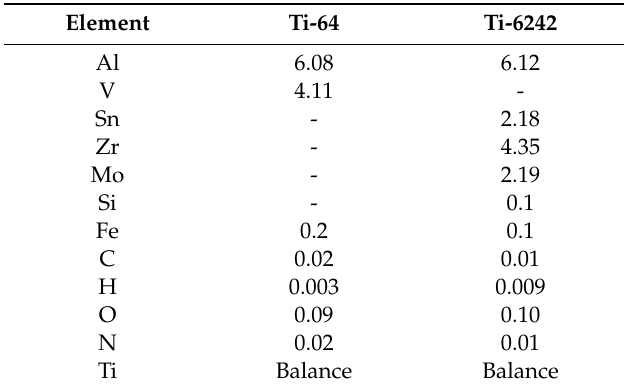
Table 1. Chemical composition of the Ti-6Al-4V (Ti-64) and Ti-6Al-2Sn-4Zr-2Mo-0.1Si (Ti-6242) parent materials (PMs)